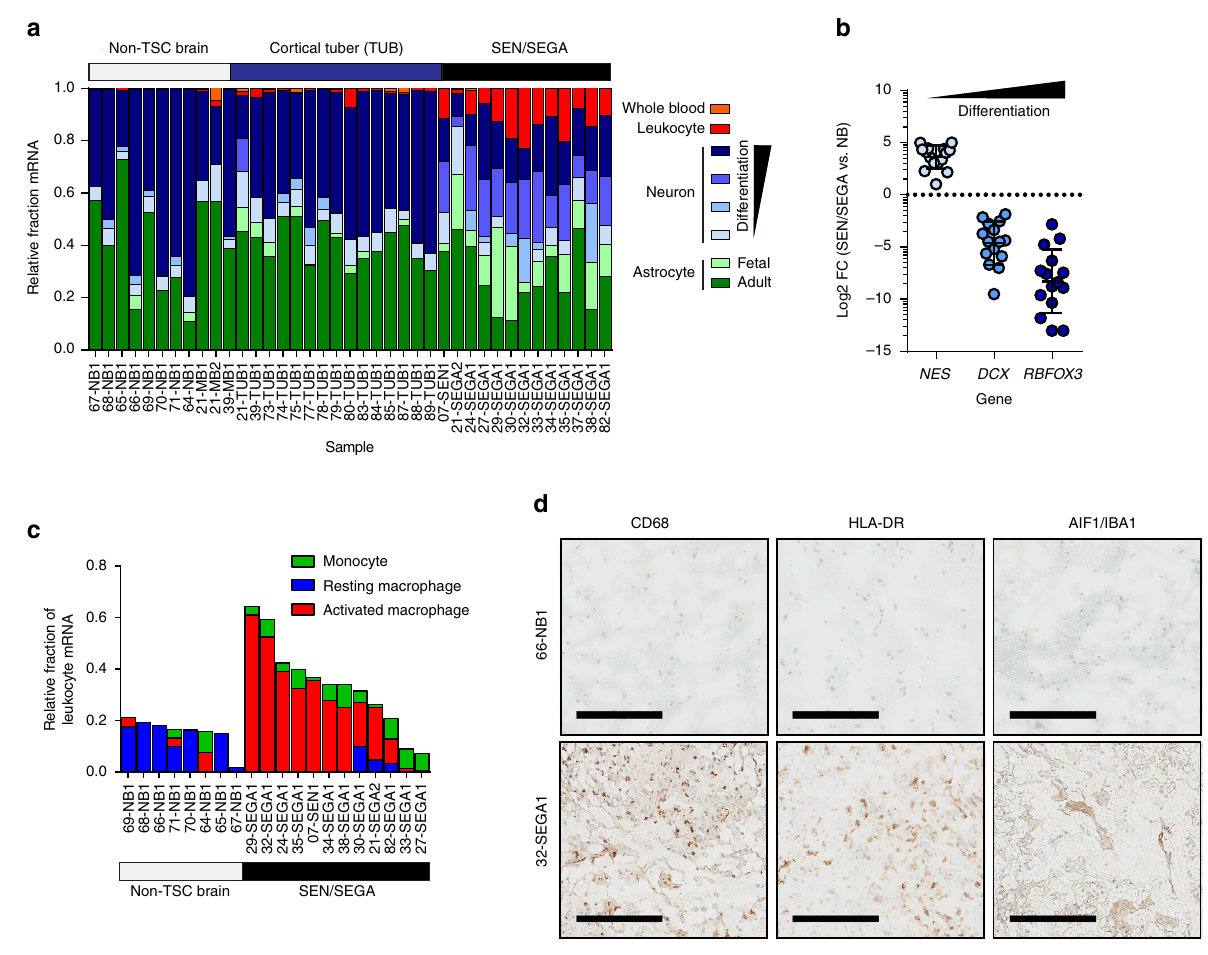
Figure 5 | Immune response is observed in TSC brain lesions. ( a ) Relative fraction of cell types estimated by CIBERSORT ( P o 0.05). Orange: whole blood; red: leukocytes; dark blue: differentiated neuron; light blue: undifferentiated neuron; light green: fetal astrocyte; dark green: adult astrocyte. ( b ) Fold-change in transcript abundance in SEN/SEGA compared to non-TSC brains for three markers of neuronal differentiation. Lines: means; error bars: s.d. ( c ) Relative fractions of 22 immune cell types estimated by CIBERSORT. Those significantly enriched in SEN/SEGA compared to NB (FDR-adjusted P o 0.05) are displayed as their relative fraction of leukocyte RNA per sample. ( d ) Fresh-frozen tissue sections from NB and SEGA were immunostained for CD68 (macrophages), HLA-DR (MHC-Class II) and AIF1/IBA1 (microglia). 66-NB1 and 32-SEGA1 are shown. Scale bars, 200 m